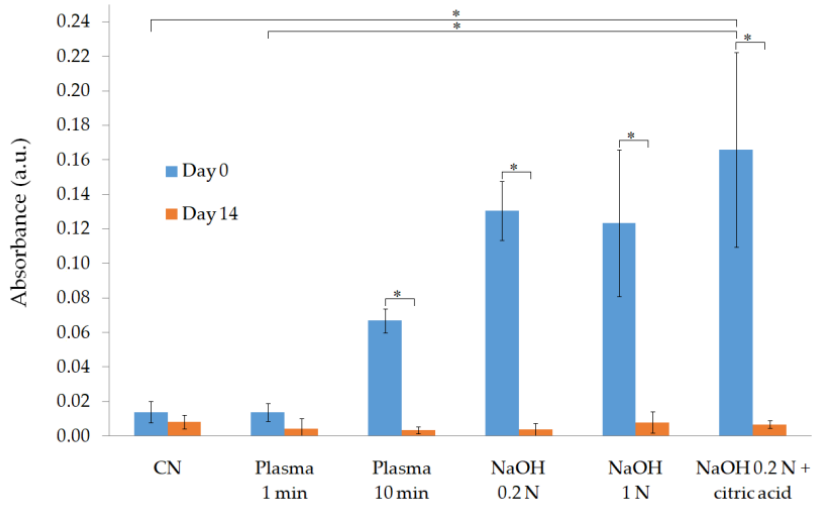
Figure 1. Physicochemical characterization of surface-treated samples by the Toluidine Blue O (TBO) test. * p < 0.05.